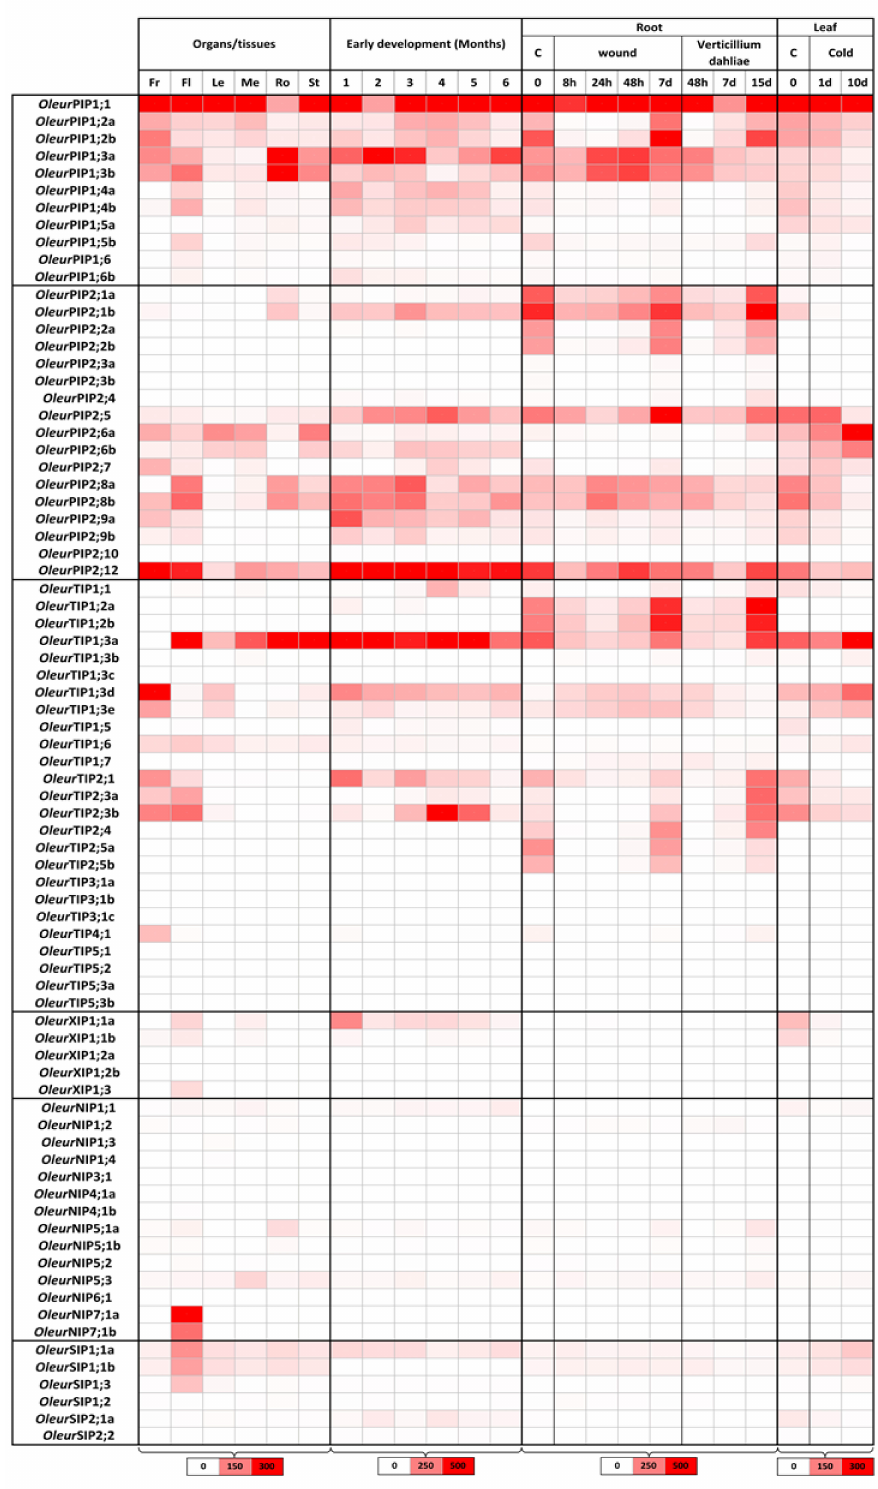
Figure 6. Expression profile of Oleur AQP genes from the cultivated Olea europaea cv. Picual in di ff erent physiological conditions. Oleur AQsP are grouped by subfamily. Fr, fruit; Fl, flower; Le, leaf; Me, meristem; Ro, root; St, stem. Control assays are marked C. h, hours post treatment; d, days post treatment. The horizontal color scales at the bottom of the figure represent the normalized expression of the aquaporins in terms of reads per kilobase of transcript per million mapped reads (RPKM). Expression levels are displayed by the depth of red, and the related values are detailed in Tables S4 and